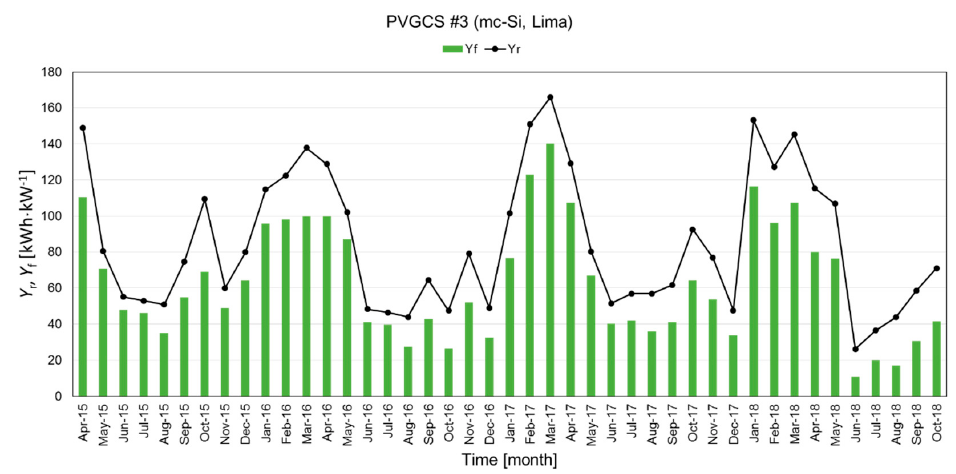
Figure 4. Values of Y r and Y f for PVGCS #3 over the period under scrutiny. Both the PV field and PVRD were left unclean.